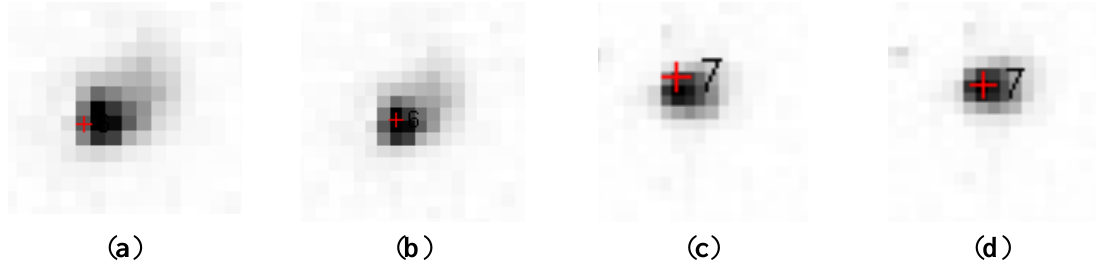
Figure 5. Refining the position of the stars: ( a ) and ( c ) are the positions estimated by rotating and translating the whole set of stars; ( b ) and ( d ) are the positions after local